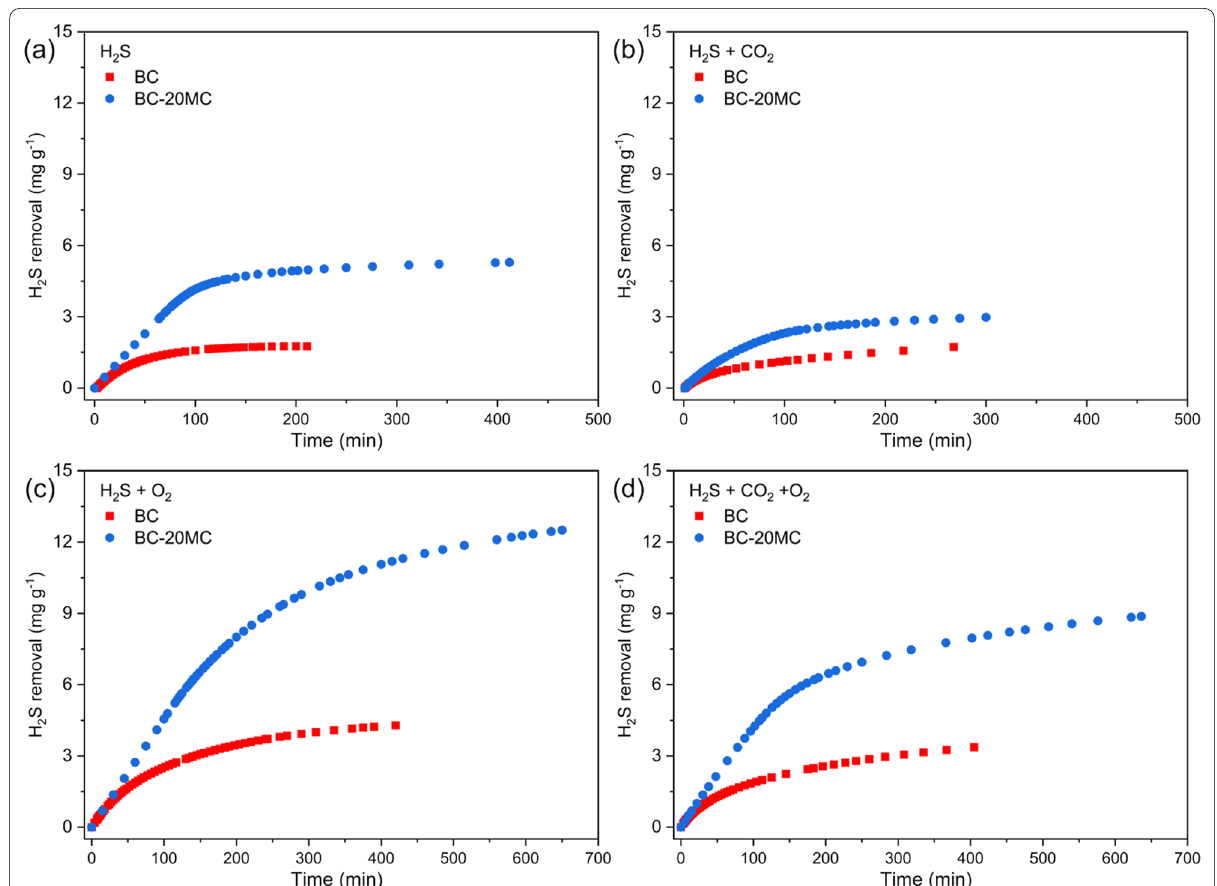
Fig. 3 Adsorption curves of H 2 S on the DFW-BC under different conditions. a is under pure H 2 S; b is under H 2 S H 2 S CO 2 O 2 . The legends in the top left indicate the syngas composition, in which H 2 S is 150 ppm, CO 2 is 40%, and O 2 is 21%; “BC” and “BC-20MC” + + mean dry DFW-BC and DFW-BC with 20% moisture content, respectively